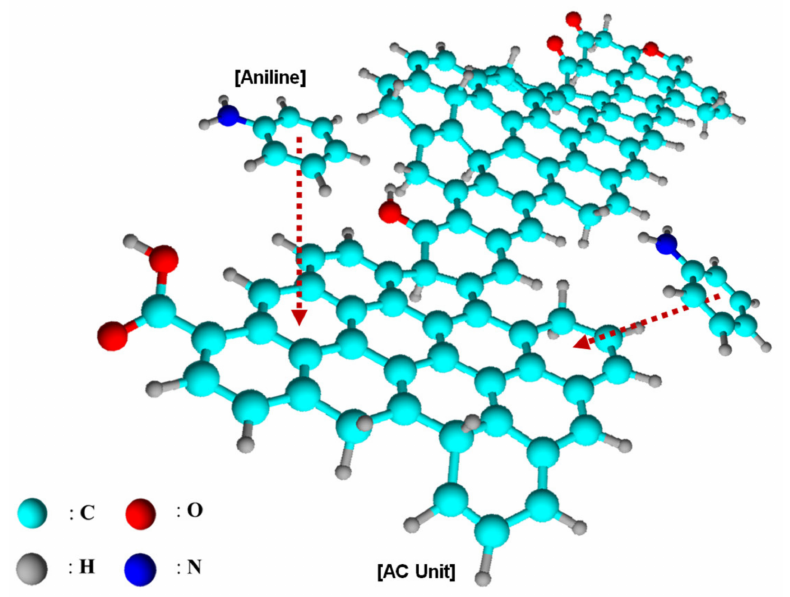
Figure 2. Conceptual diagram of impregnated aniline on the surface of activated